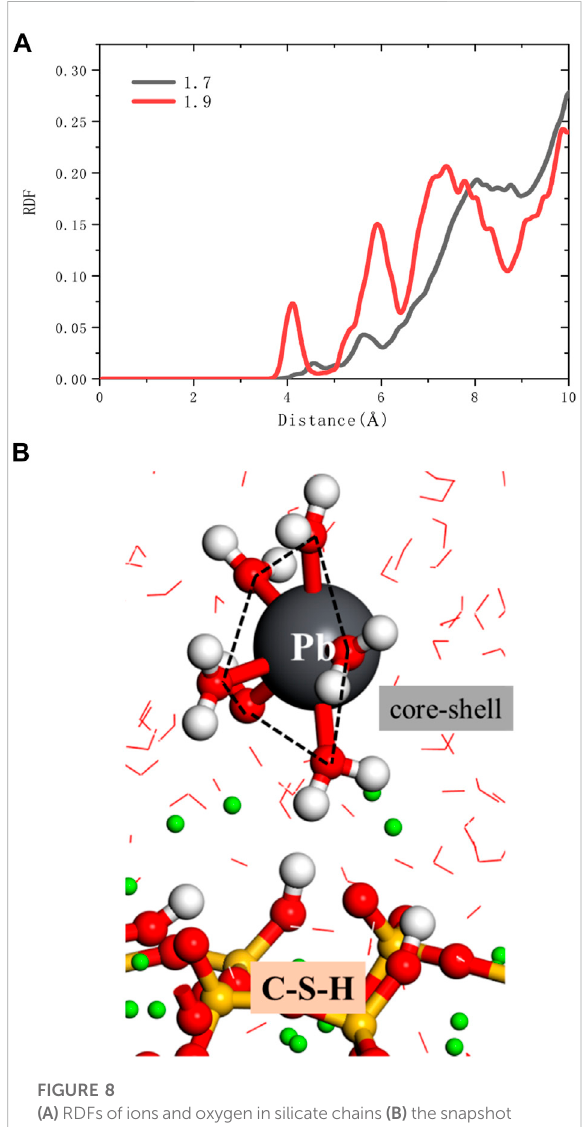
FIGURE 8 (A) RDFsofionsandoxygen insilicatechains (B) thesnapshot of Pb2+ adsorption outside the C-S-H interphase